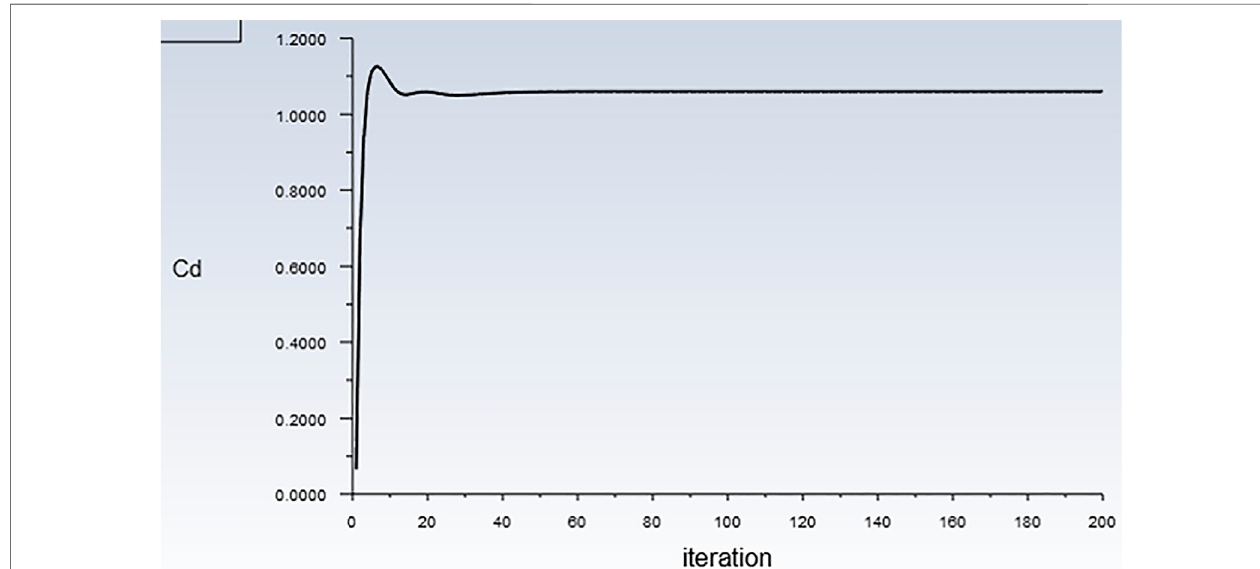
FIGURE 1 | The iterative curve of the drag coef fi